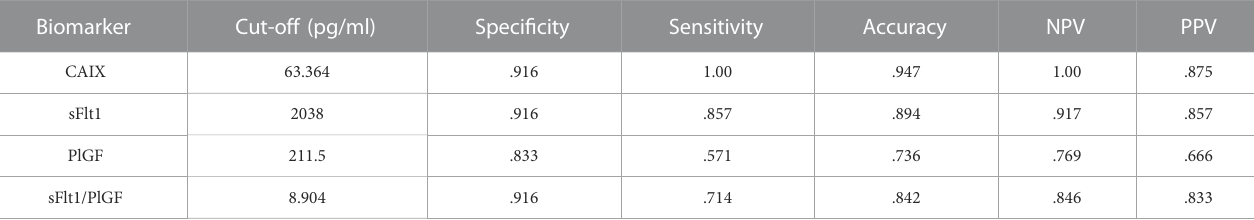
TABLE 3 Speci fi city, sensitivity, accuracy, negative predictive value (NPV), and positive predictive value (PPV) of the different biomarkers.